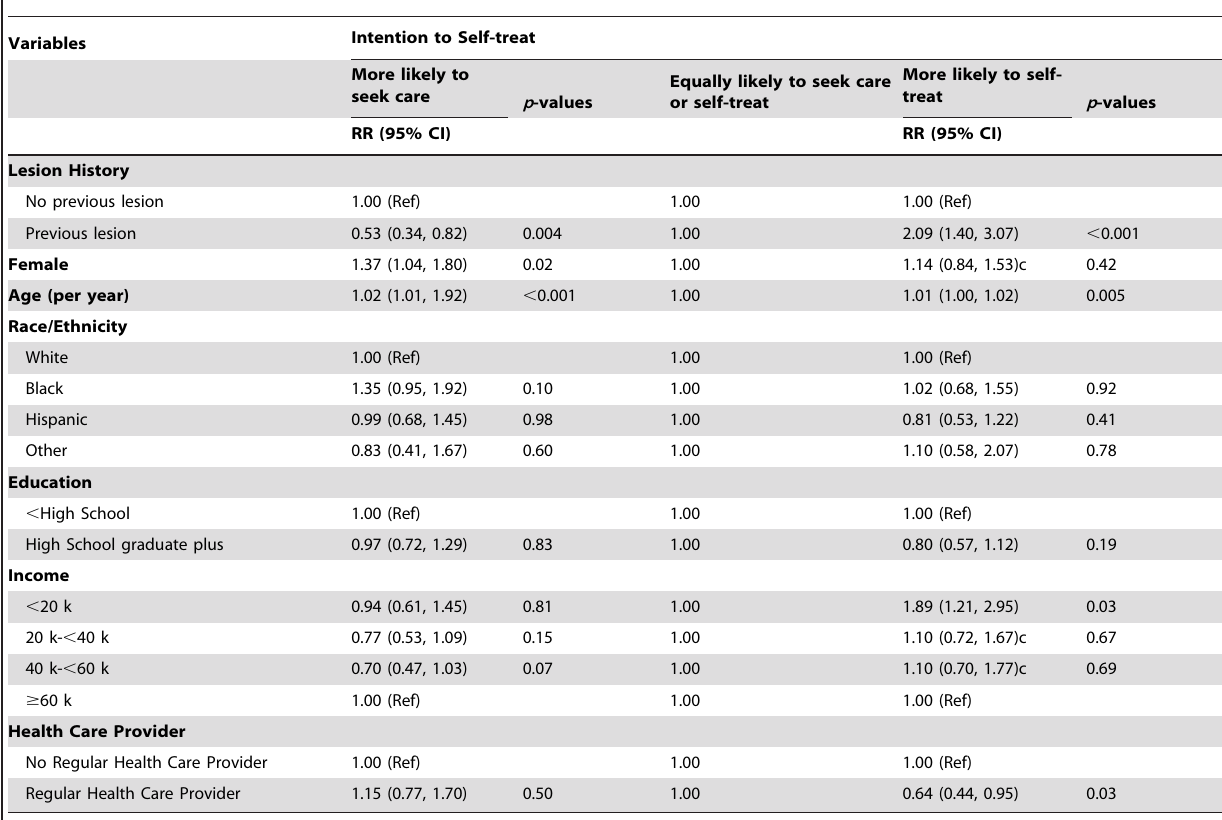
Table 6. Multinomial Regression Analysis of Intention to